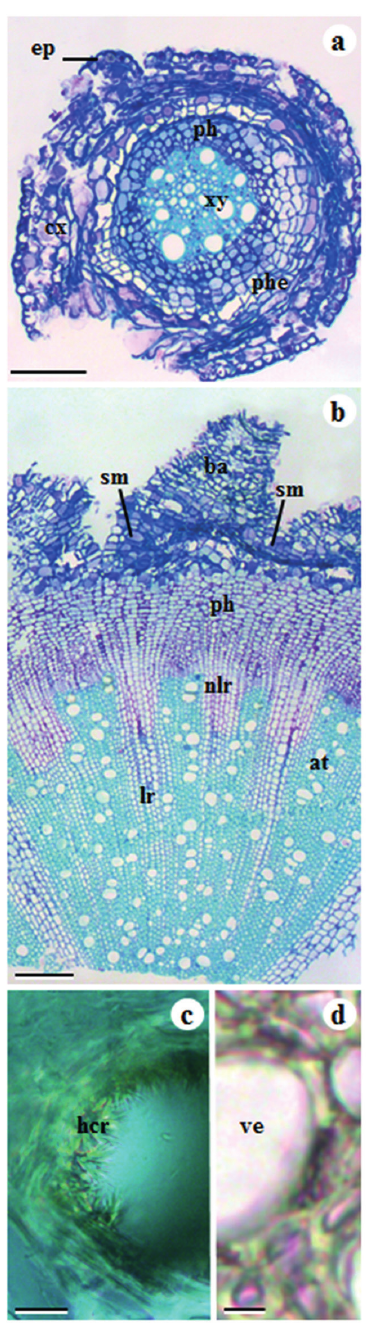
Figure 4 - Structural characterization of Hesperozygis ringens root in transversal sections. (a) Epidermis (ep), cortex (cx), phellogen (phe), phloem (ph), xylem (xy). (b) Bark (ba), secondary metabolites (sm), phloem (ph), non lignified rays (nlr), lignified rays (lr), axial tissue (at). (c) Detail of vessel element highlighting hesperidin crystals (hcr). (d) Detail of vessel element (ve). Scale bars: 10 µm (c and d) , 200 µm (a and b)